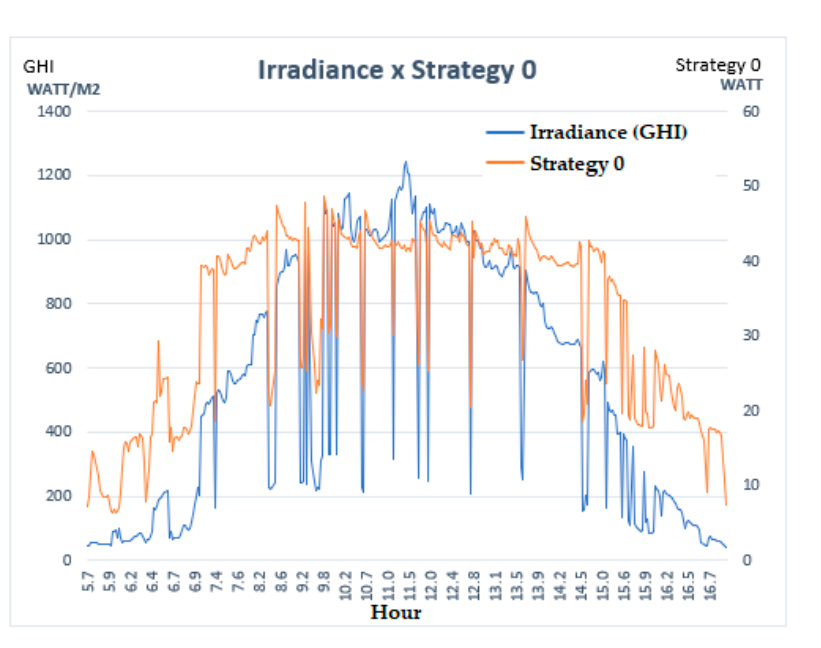
Figure 7. The power received by strategies 0, 1 and 2 for comparison. Starting from the Figure 8, it can be shown that the sun ray unity vector, 𝑛 (cid:3046) , can be expressed in the form: 𝑛 (cid:3046) = (cos δ cos ω cos 𝛽 0 - sin δ sin 𝛽 0 , - cos δ sin ω , cos δ cos ω sin 𝛽 0 + sin δ cos 𝛽 0 )